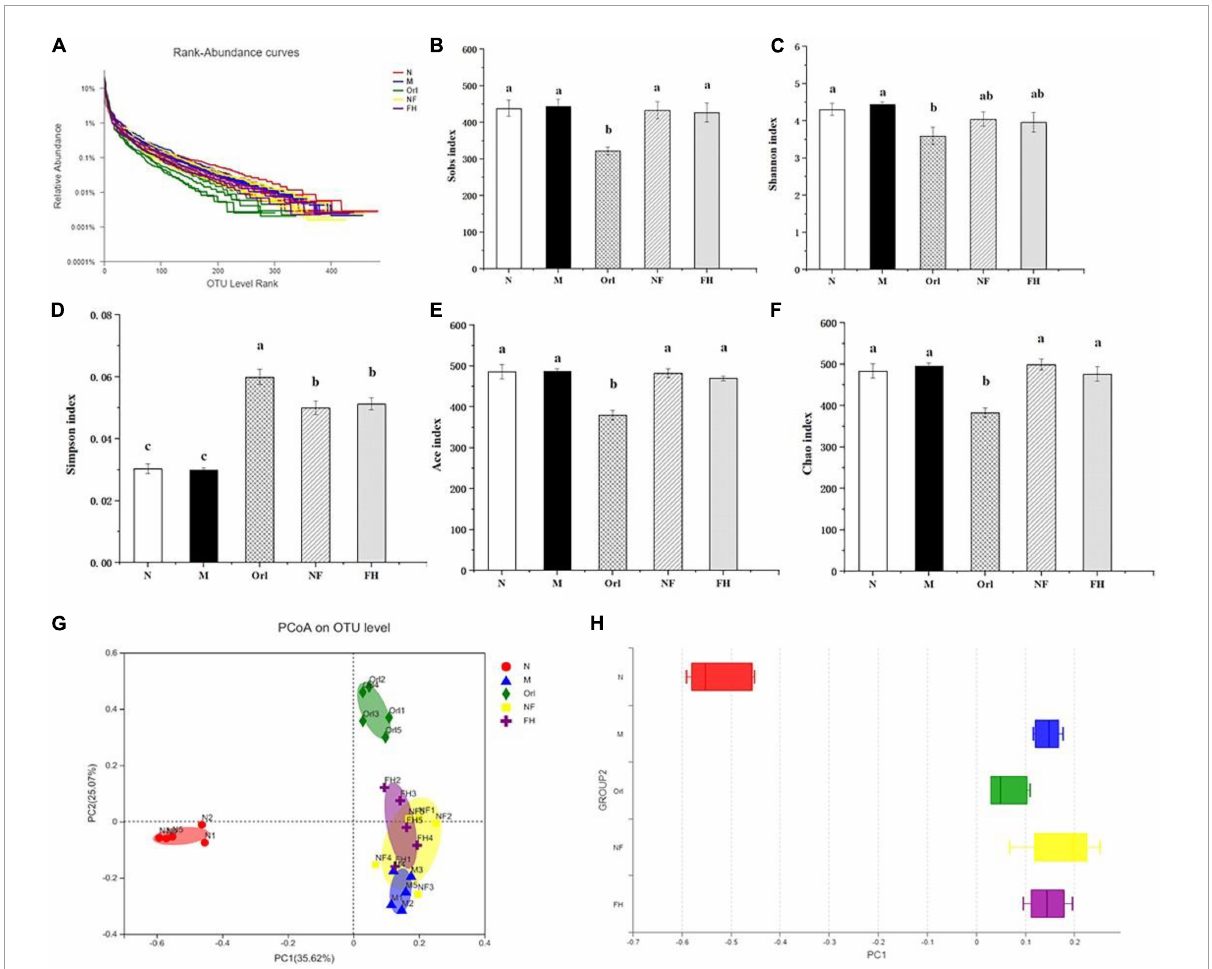
FIGURE5 Effects of FAK on gut microbes in mice. (A) Rank-Abundance curves. (B–F) Sobs, Shannon, Simpson, Ace, and Chao indices. (G) PCoA analysis. (H) Statistical analysis of PCoA. All data are expressed as mean ± SD ( n = 5). (a–c) Bands with different letters indicate significant differences ( P <